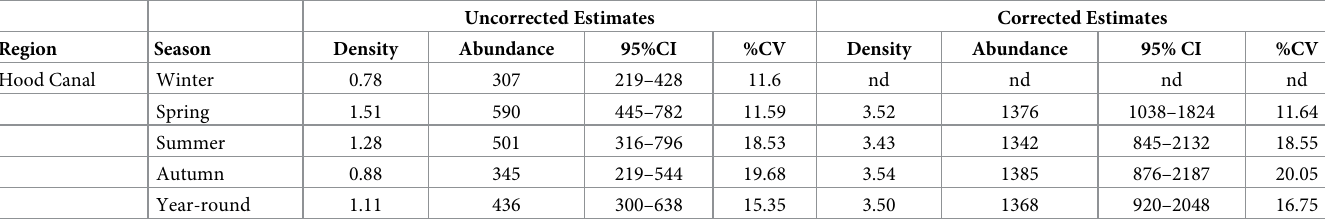
Table 4. Density and abundance estimates for inland Washington harbor seals, Hood